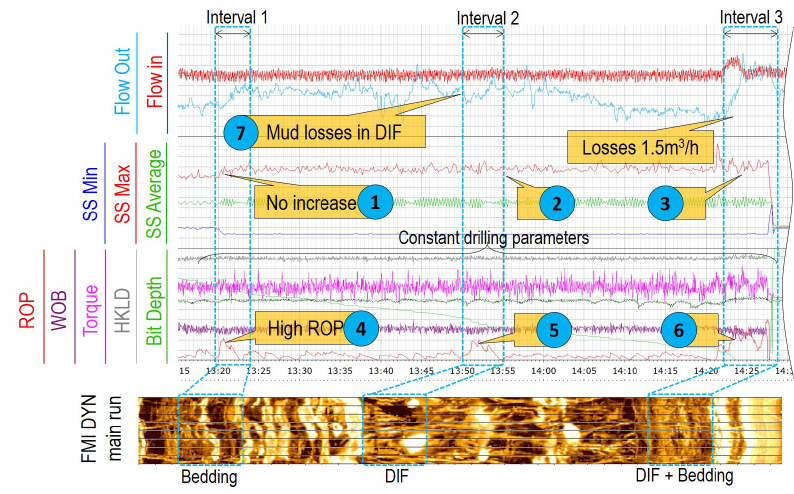
Figure 10. Drilling in the intervals of bedding and drilling induced fractures. Standard and flow data (Well #5).